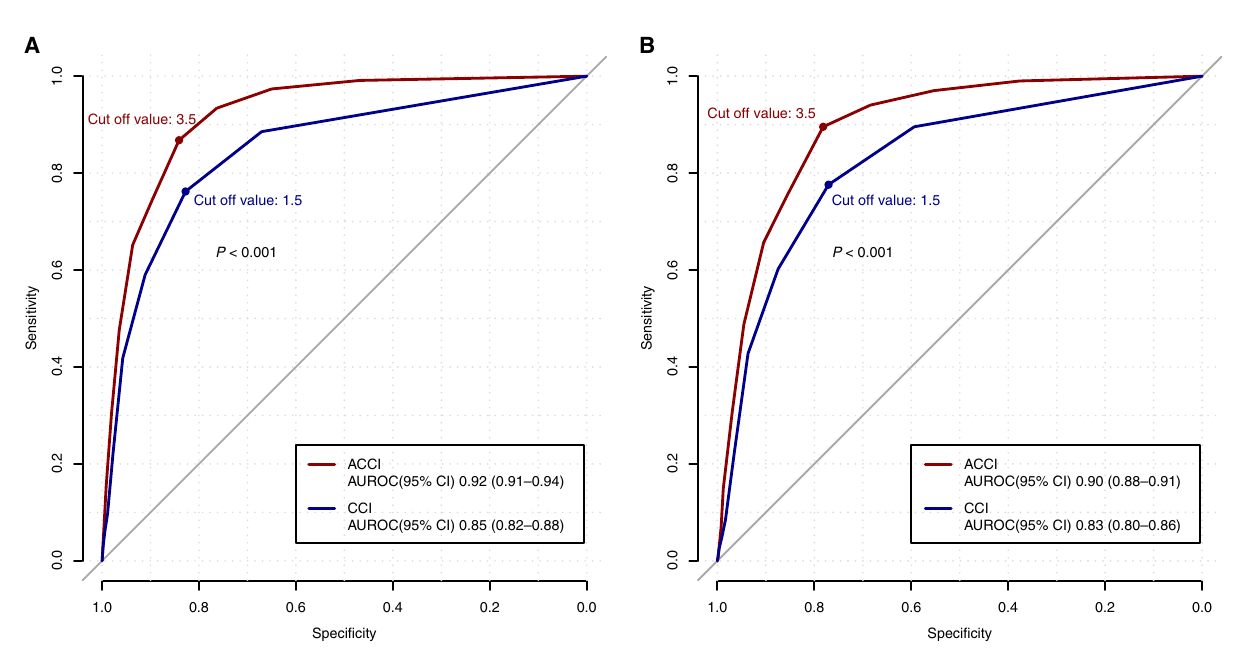
Figure 3. The area under the receiver operative characteristic curves of the Charlson comorbidity index (CCI) for predicting the mortality of all the patients ( A ) and patients living in the Daegu–Gyeongbuk region ( B ) with COVID-19. The blue and red lines represent the unadjusted and age-adjusted CCI, respectively. ACCI age- adjusted Charlson comorbidity index, AUROC area under the receiver operating characteristic, CI confidence interval. R: A language and environment for statistical computing. R Foundation for Statistical Computing, Vienna, Austria. https:// www.R- proje ct.